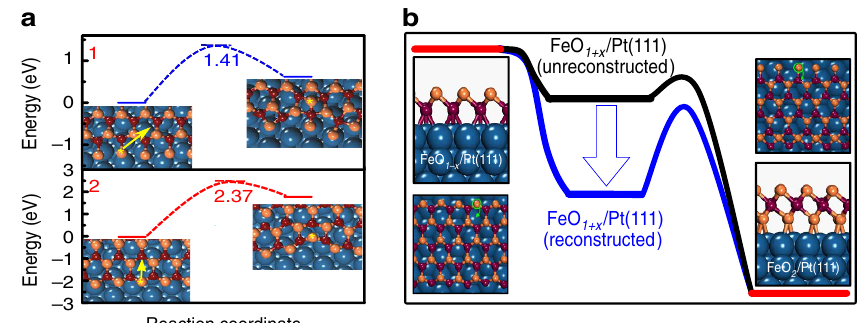
Figure 4 | Dynamic size effect on the oxidation of FeO NSs. ( a ) Potential energy diagram depicting the mode of action for oxygen reconstruction. The diffusion pathways and barriers are displayed for oxygen penetration into the FeO–Pt(111) interface from the unreconstructed edge (1) and the reconstructed CUO edge (2). ( b ) A schematic illustration of the dynamic size effect in enhancing the oxidation resistance of active FeO NSs. The dynamic response of FeO NS enables FeO to reach an intermediate state, which has a lower total energy than that before the reconstruction and thus increases the barrier for